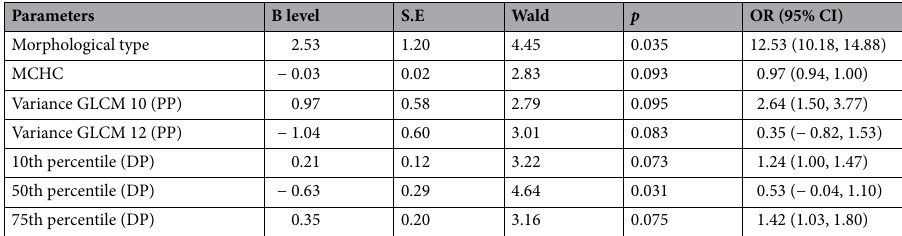
Table 4. Multivariable binomial logistic regression results for predicting HER2 status in the primary cohort. S.E. standard error, OR odds ratio, CI confidence interval, MCHC mean corpuscular